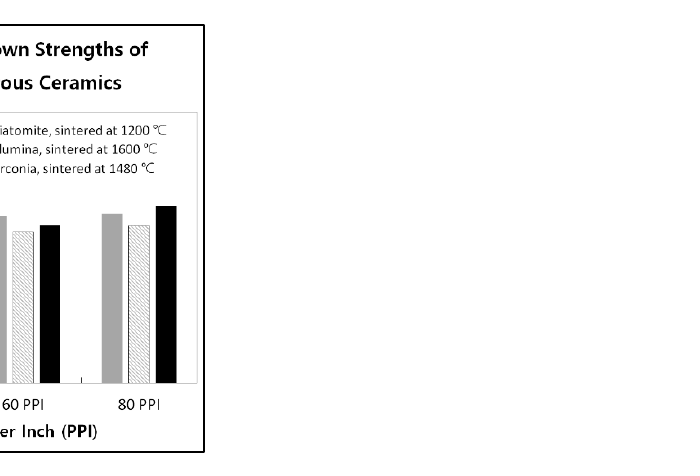
Figure 12. Dielectric breakdown strengths of reticulated porous diatomite-kaolin reticulated porous alumina and reticulated porous zirconia specimens with pore densities of 45, 60, and 80 PPI.